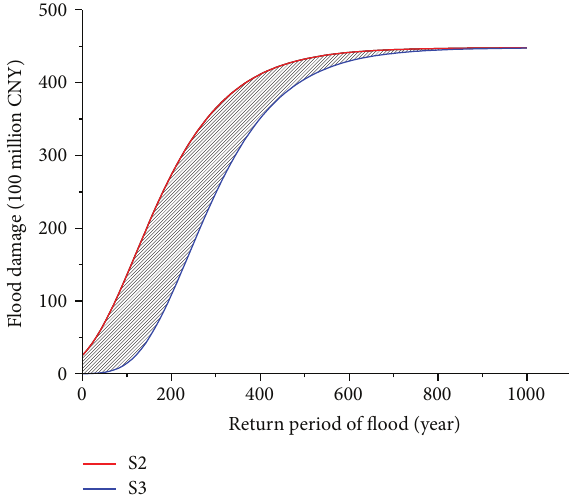
Figure 10: The impact of flood control capability development.